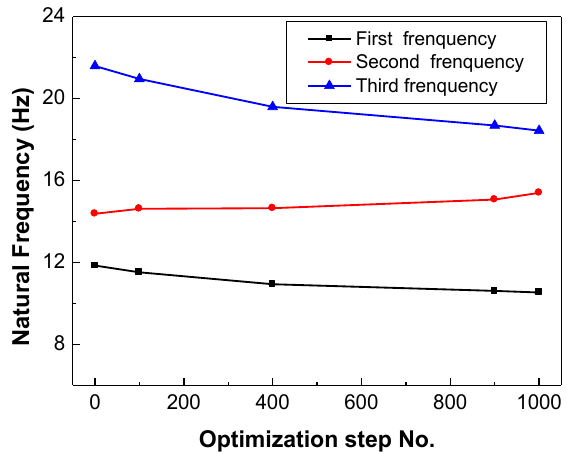
Figure 14. Evolution of the first three natural frequencies of Model 2 during the optimization process.